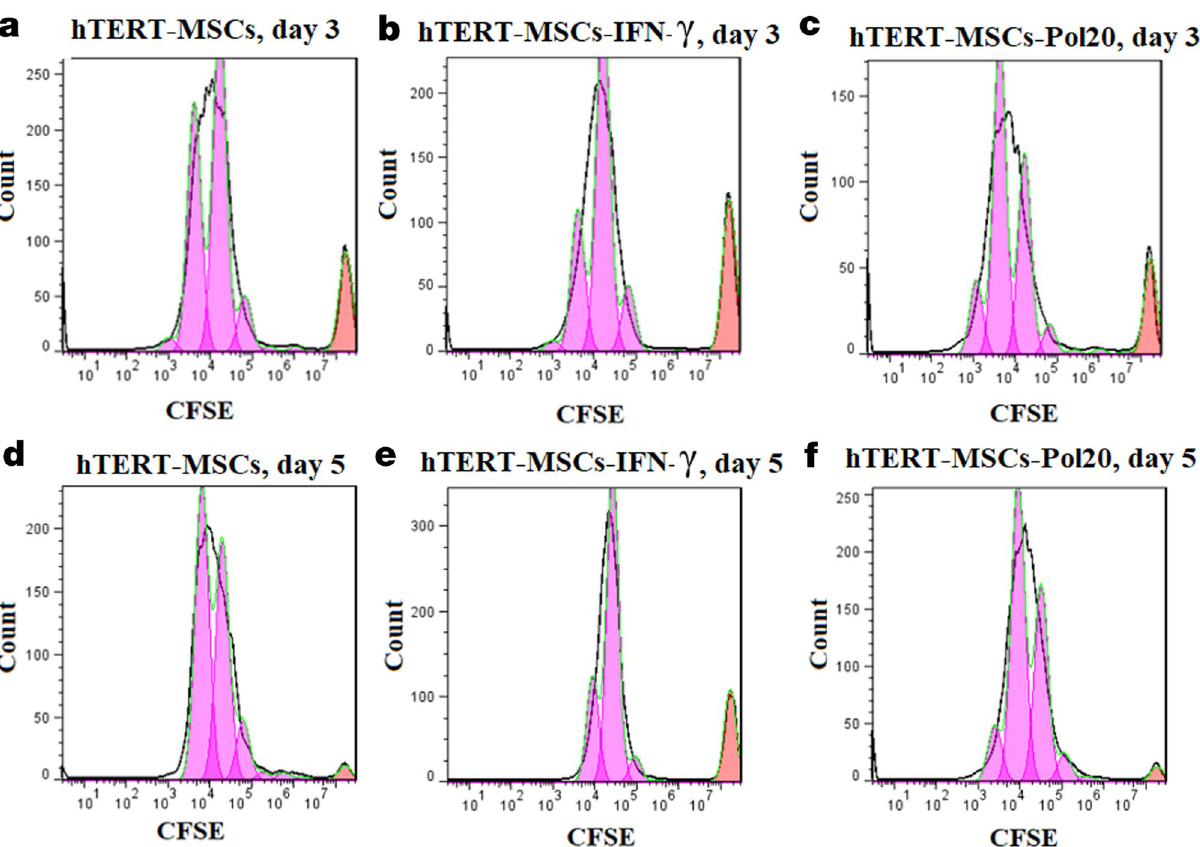
Figure 7. Lymphocyte inhibition assay (CFSE analysis). Results from flow cytometric analysis of the inhibitory effects of hTERT-MSCs against Jurkat cells following 3 to 5 days of co-culture experiments. ( a , d ) untreated hTERT-MSCs, ( b , e ) IFN-γ (250 U/ml)-primed and ( c , f ) poly(I:C) (20 µg/ml)-primed cells after 72 h and 120 h of culture, respectively. 3 µg/ml of PHA was applied as cell proliferation stimulant for Jurkat cells. IFN-γ priming of the cells resulted in lower percentage of divided cells and decreased amounts of division index in both investigated time periods in comparison to untreated cells (Jurkat cells: MSCs ratio 10:1). Data were obtained by BD Accuri C6 and analyzed using FlowJo Software (version